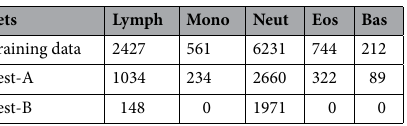
Table 7. The number of samples in training data, test-A, and test-B.